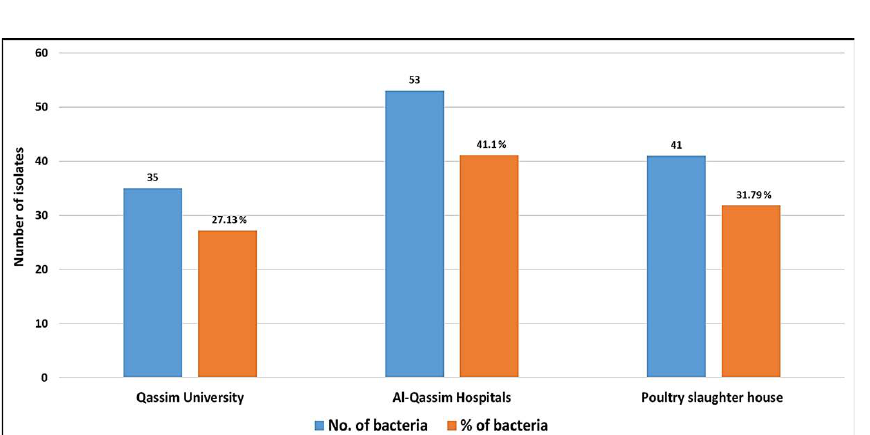
Fig. 2. Numbers and percentages of various airborne pathogens isolated from three different areas in Al-Qassim region table 3. Log (score) values of airborne pathogens identified by MALDI Biotyper Species Total no. Log (score) values of isolates 0.000-1.699